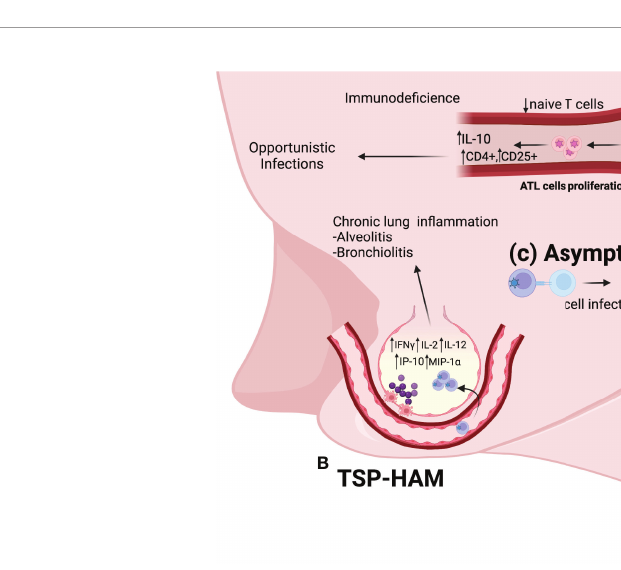
FIGURE 1 | (A) ATL: ATL cell proliferation leads to a reduction in the number of naive T cells, a increase in the number of T reg cells (CD4+ and CD25+), and increased expression of anti-in fl ammatory cytokines (IL-10). Pneumopathies in these individuals are mainly caused by opportunistic diseases. (B) TSP-HAM: The high expression of in fl ammatory cytokines (IFN g , IL-2, and IL-12) and chemokines (IP-10 and MIP-1 a ) results in an exacerbated immune response and chronic lung in fl ammation (Alveolitis and bronchiolitis). (C) HTLV-1 asymptomatic carriers: The low expression of TNF a , IL-17, and IL-1b causes mild immunode fi ciency in these individuals, with a higher risk of infection by Mycobacterium tuberculosis